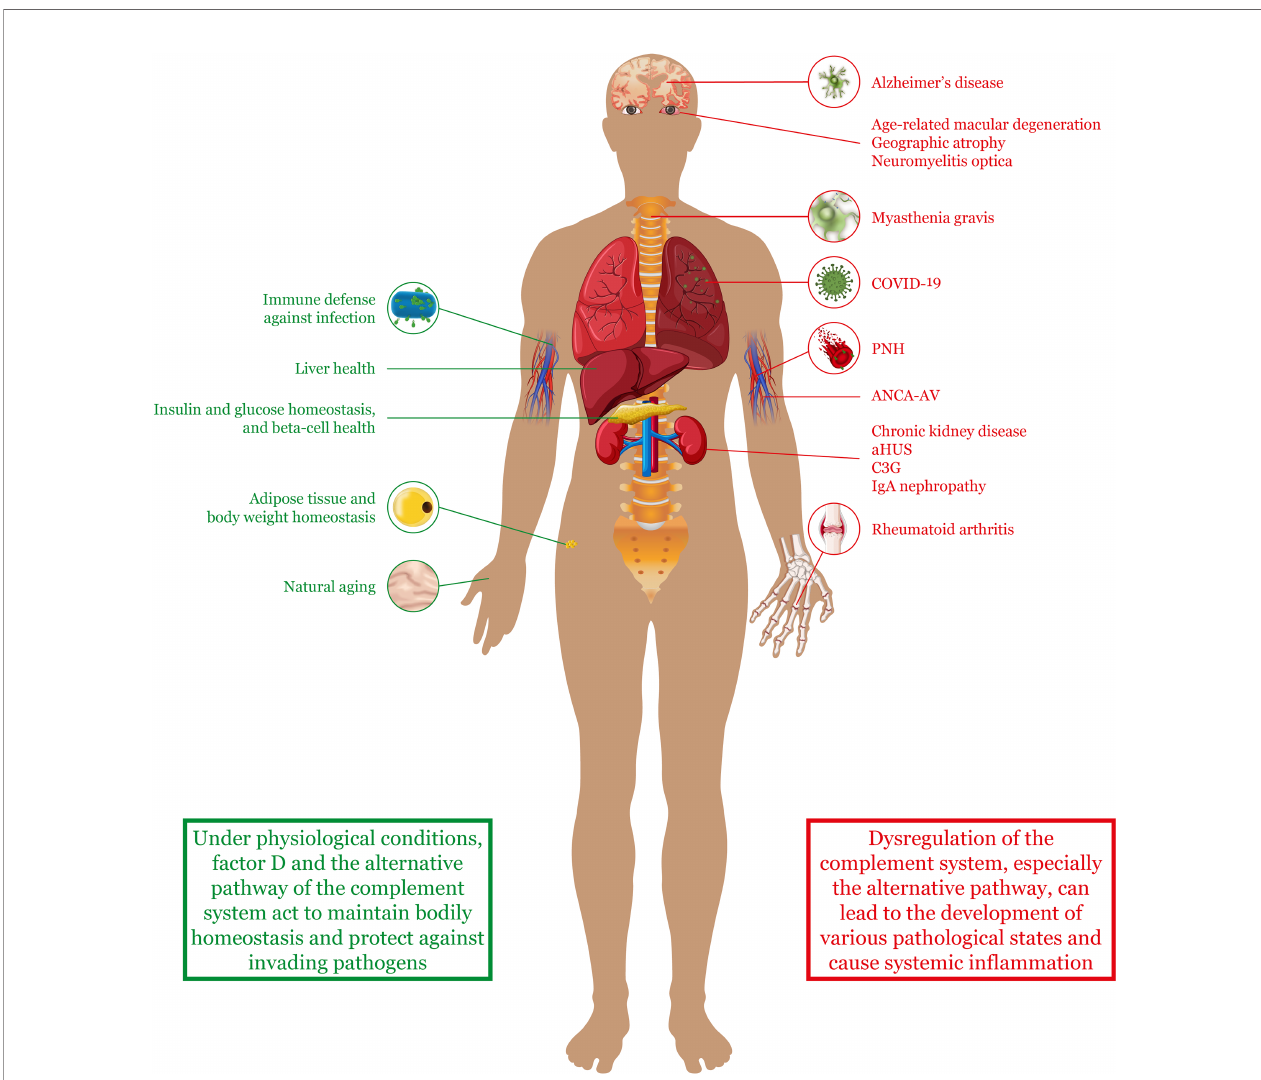
FIGURE 2 | The alternative complement pathway in health and disease. Factor D and the alternative complement pathway have been implicated in both healthy states and disease states. Under normal conditions, the pathway helps to protect against invading pathogens and maintain homeostasis and health of various tissues and organs. However, upon dysregulation, the alternative complement pathway can contribute to the pathogenesis of various diseases throughout the body. Although these diseases can affect speci fi c organs or tissues (as indicated in the fi gure), many of them are also characterized by systemic complications and widespread in fl ammation. aHUS, atypical hemolytic uremic syndrome; ANCA-AV, anti-neutrophil cytoplasmic antibody – associated vasculitis; COVID-19, coronavirus disease 2019; C3G, complement 3 glomerulopathy; PNH, paroxysmal nocturnal